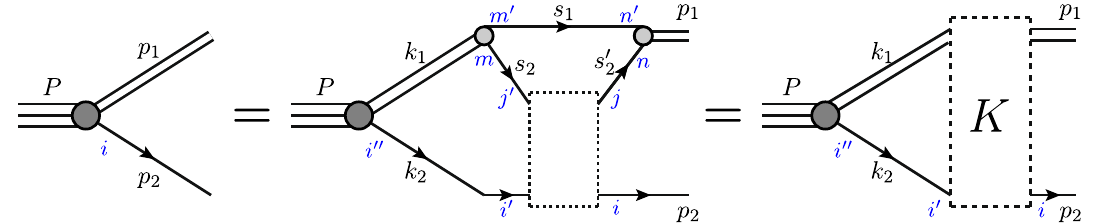
Fig. 4 Bethe–Salpeterequationofthebaryonbasedonthediquark–quarkpicture. P denotesthebaryonmomentum, p 1 ( k 1 ) ,thediquarkmomentum, and p 2 ( k 2 ) , the third quark momentum ; The Romans (blue) denote the Dirac indices